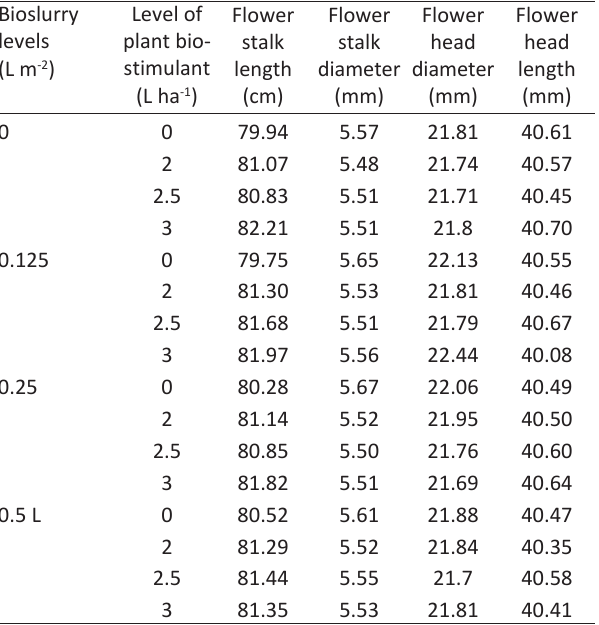
Table 3 - Residual effects of the interaction of bioslurry and plant biostimulant on carnation flower quality Level Bioslurry levels